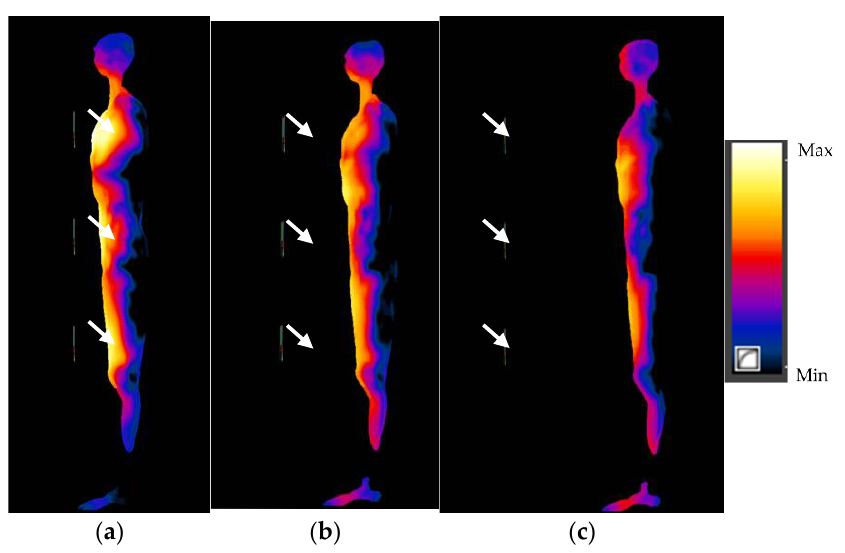
Figure 6. SAR distributions in the human body exposed to EMF near a UHF I-RFID two-antenna reader located 5 cm from the body: ( a , b ) in the body’s sagittal cross-sections through the body’s main axis and 6 cm to side (through the leg) in scenario EF and ( c ) in the body’s frontal cross-section in scenario ES; antennas marked with white arrows.